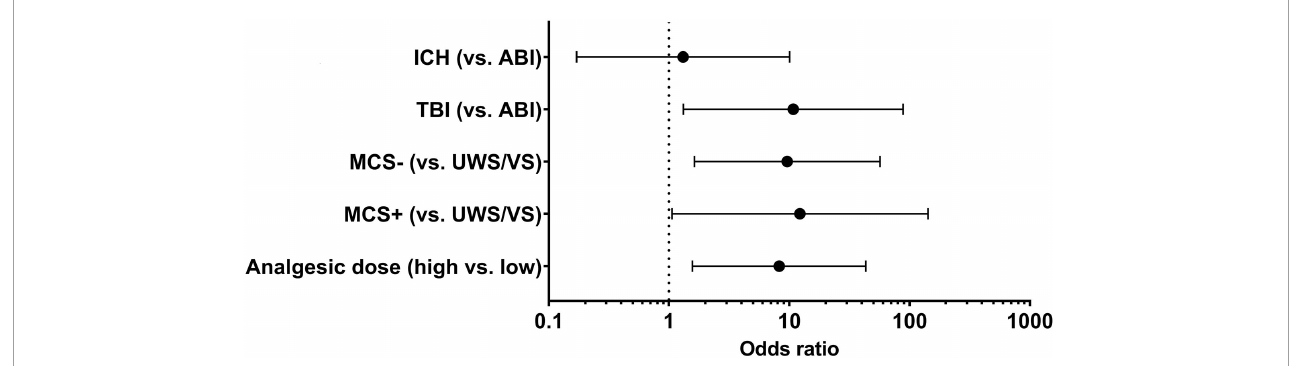
FIGURE1 Relative factors of postoperative improvement in DoC patients. In multivariate logistic regression, the etiology (TBI vs. ABI: OR, 10.77; 95% CI, 1.31–88.43; p = 0.027), preoperative diagnosis (MCS– vs. VS: OR, 9.6; 95% CI, 1.63–56.73; p = 0.013; MCS+ vs. VS: OR, 12.26; 95% CI, 1.06–142.07; p = 0.045), and opioid analgesic dose (high vs. low: OR, 8.2; 95% CI, 1.56–43.23; p = 0.013) were independently associated with the postoperative improvement in DoC patients. TBI, traumatic brain injury; ICH, intracerebral hemorrhage; ABI, anoxic brain injury; UWS/VS, unresponsive wakefulness syndrome/vegetative state; MCS, minimally conscious